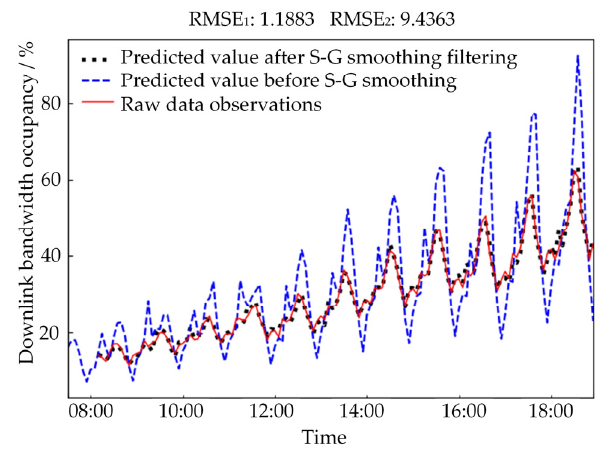
Figure 14. Model prediction comparisons.